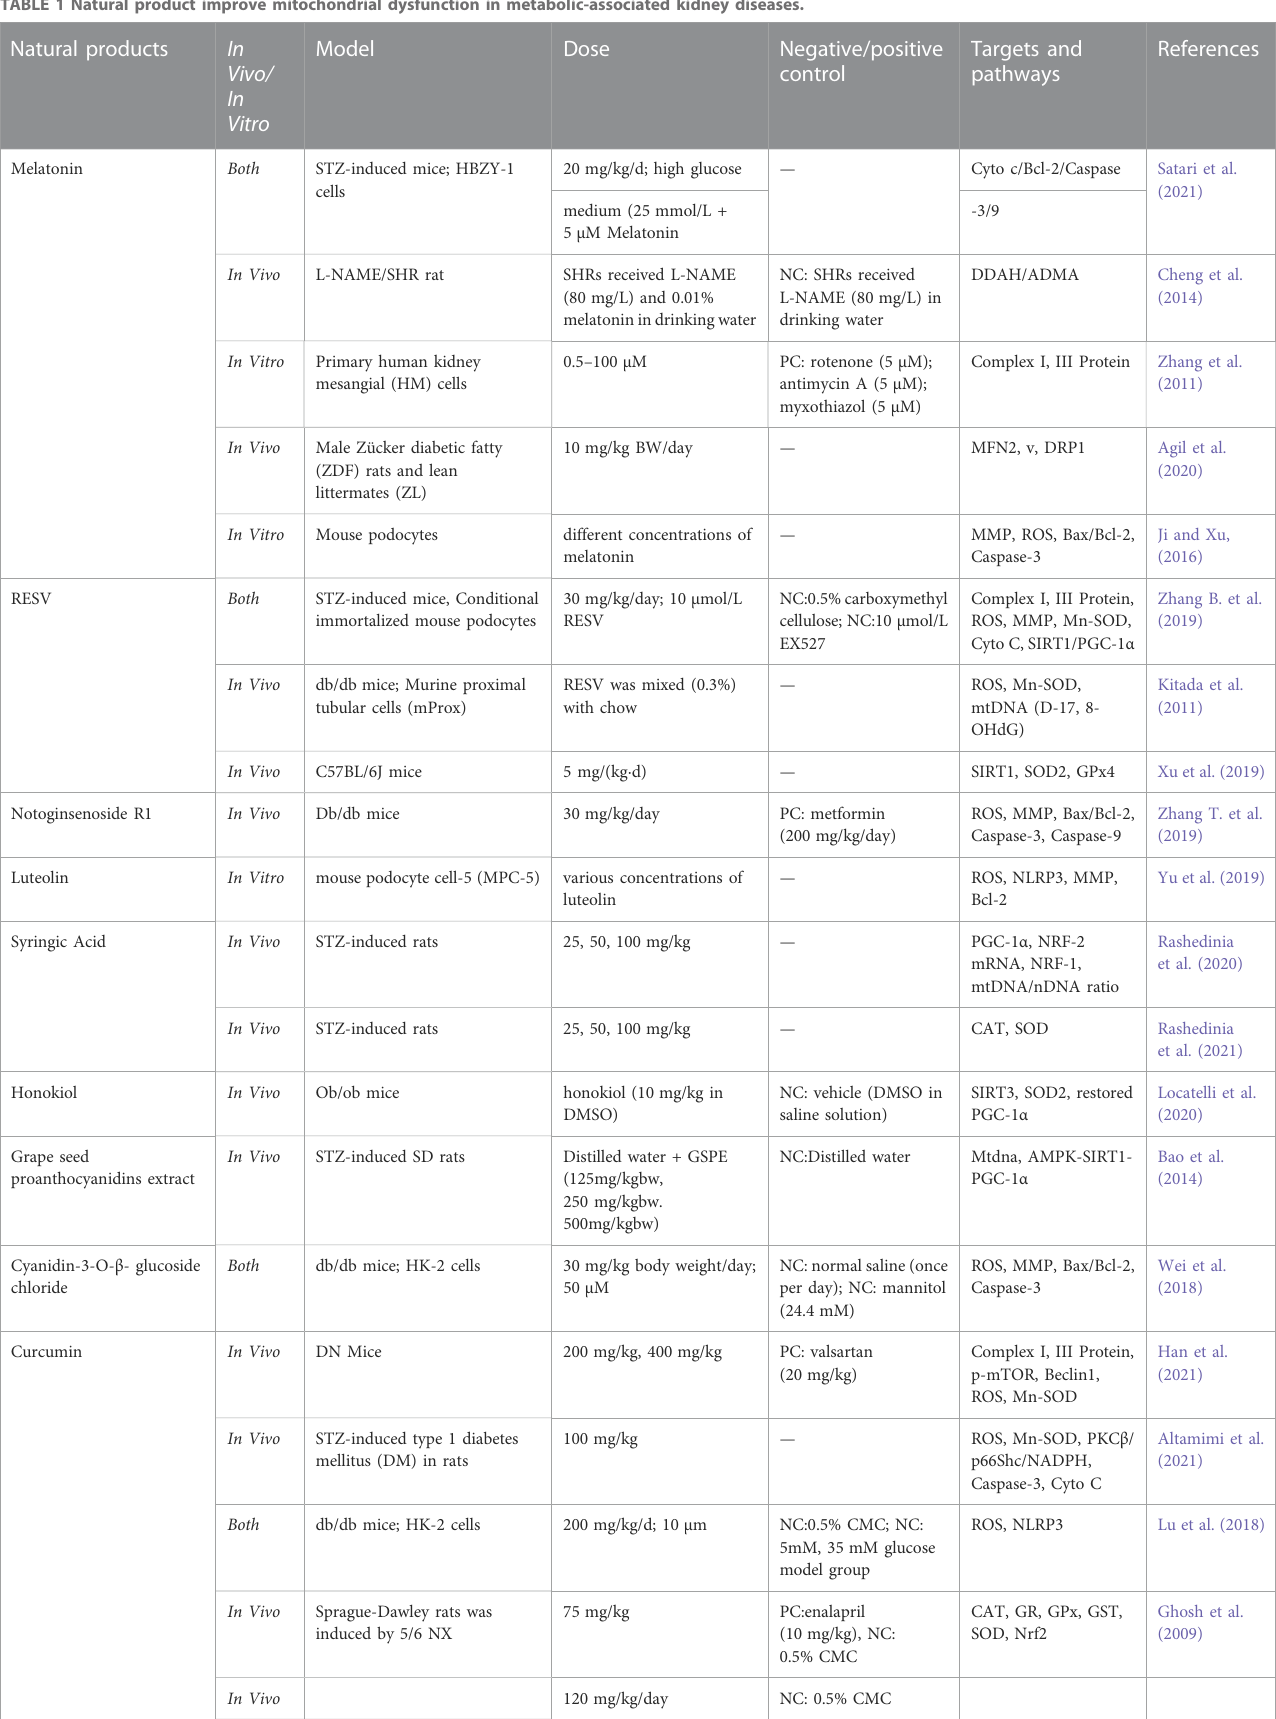
TABLE 1 Natural product improve mitochondrial dysfunction in metabolic-associated kidney diseases. Natural